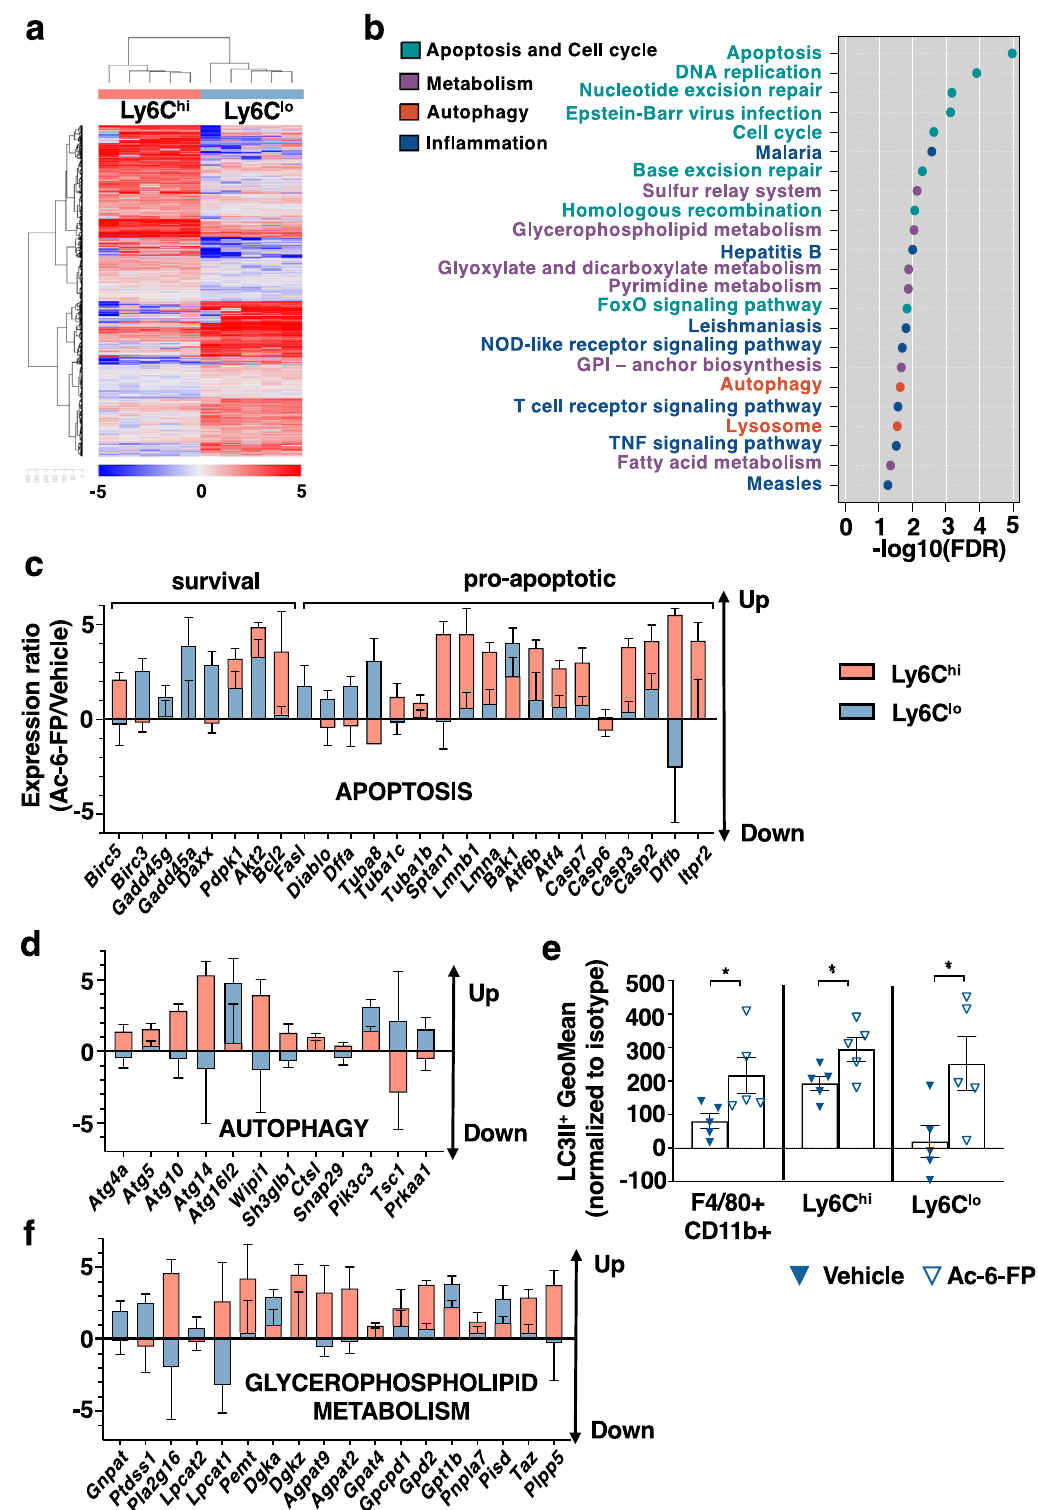
Fig. 4 | Blocking MAIT cell activation impacts on the Ly6C hi vs Ly6C lo macro- phagesignature.a Heatmapofthe2687geneswithasigni fi cant( p ≤ 0.05,paired t test)differenceintheratioofLy6C hi Ac-6-FP/vehicleandLy6C lo Ac-6-FP/vehicleand afoldchange ≥ 1.5.ClusteringusedEuclideandistanceandWard.D2agglomeration method. b Top KEGG pathways from the enrichment analysis based on the 2687 genes with a signi fi cant difference in the ratio of Ly6C hi Ac-6-FP/vehicle vs Ly6C lo Ac-6-FP/vehicle. KEGG pathways are ordered by − log10(FDR). c Ac-6-FP/mean vehicle ratios in Ly6C hi (red) and Ly6C lo (blue) for selected genes from Apoptosis (mmu04210)and d Autophagy(mmu04140)KEGGpathways. e GeometricMeanof